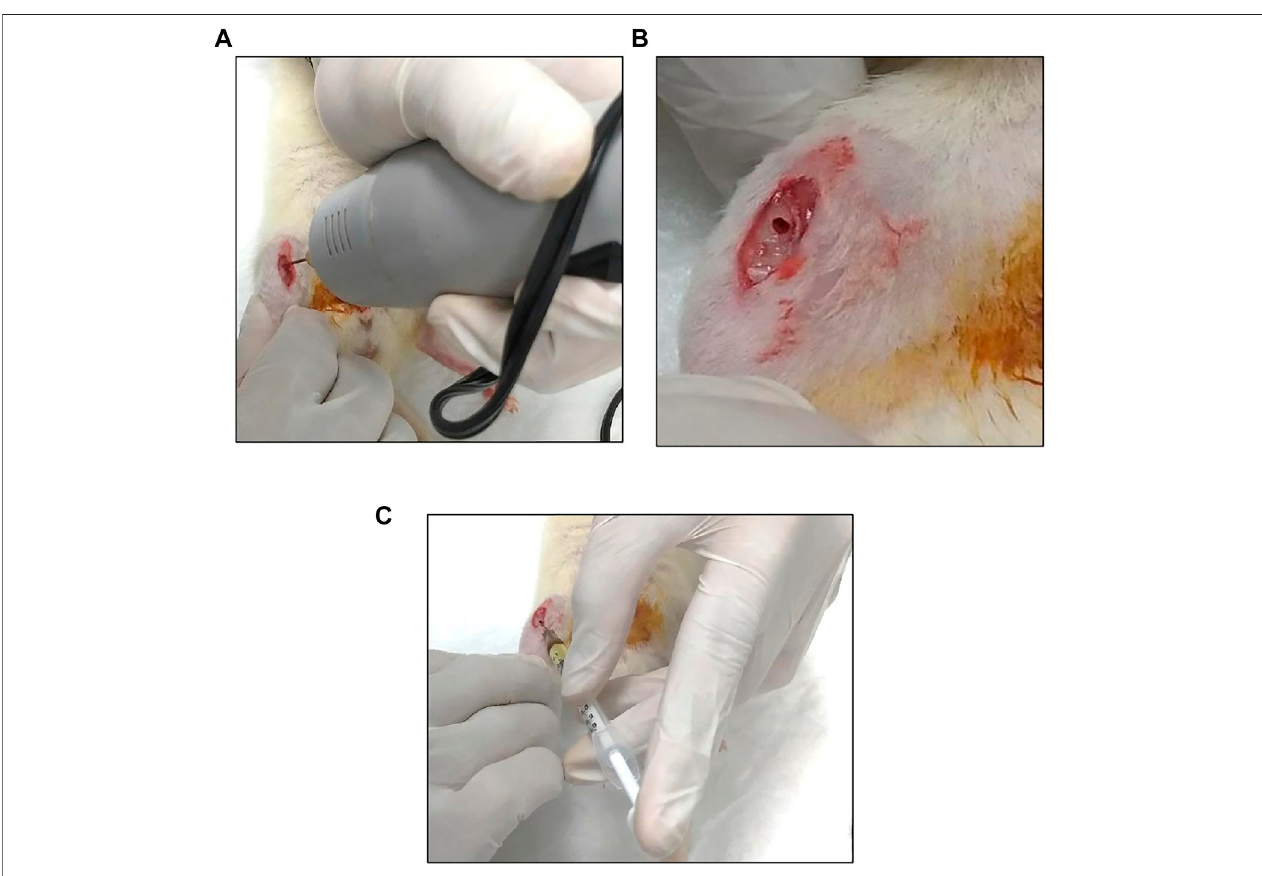
FIGURE 1 | Procedures for intraosseous (IO) injection of the treatment agent to the tibial bone. (A) The tibia was drilled using a 1.0-mm drill bit. (B) The burr hole at the exposed tibia. (C) One time-IO injection of poly lactic-co-glycolic acid (PLGA)/tocotrienol combined with PLGA using a 26-G needle.